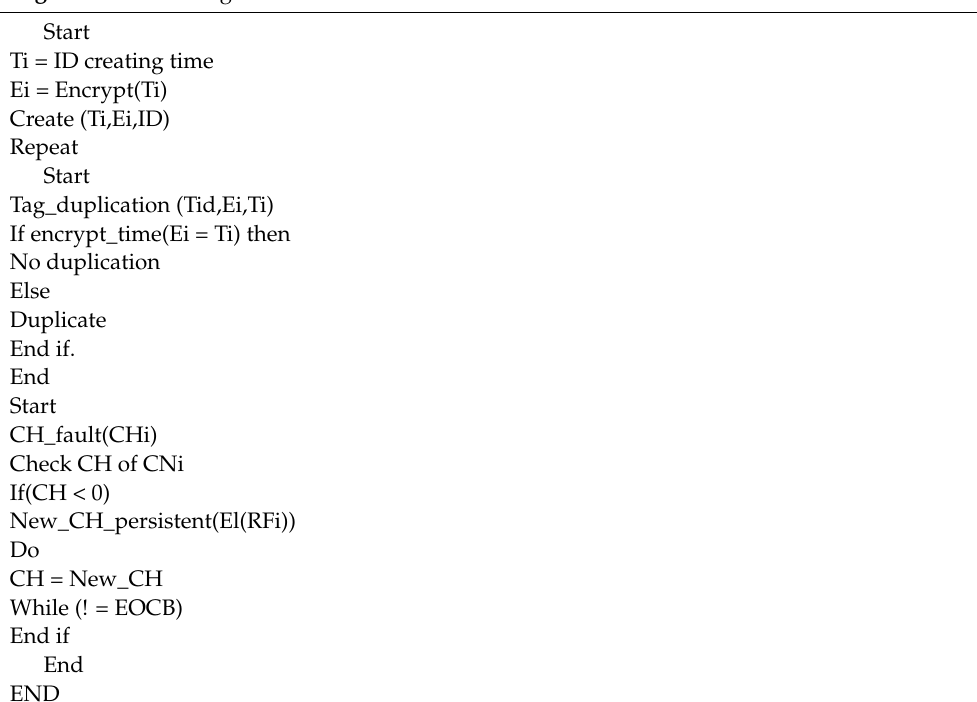
Algorithm 2 denotes the cluster head failure and detection of tag duplication.